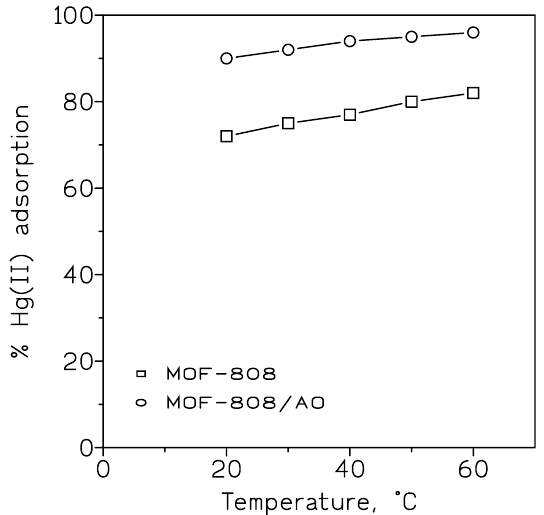
Figure 2. Percentage of Hg(II) adsorption at various temperatures. Aqueous phase: 0.2 g / L Hg(II) at Figure 2 . Percentage of Hg(II) adsorption at various temperatures. Aqueous phase: 0.2 g/L Hg(II) at pH 5. pH 5. Adsorbents dosage: 5 g / L. Time: 80 Adsorbents dosage: 5 g/L. Time: 80 min.